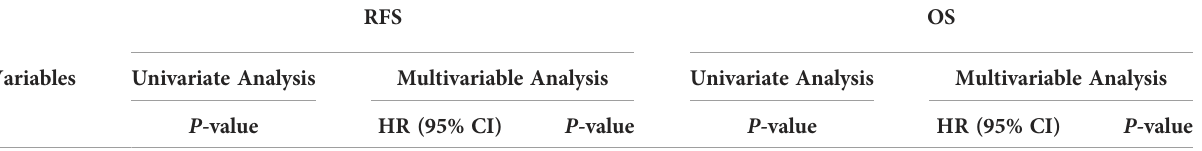
TABLE 3 Univariate and multivariate analyses of recurrence-free survival and overall survival in patients before propensity score